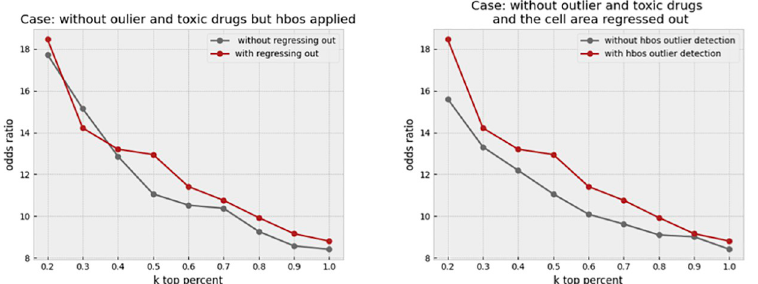
Fig 15. The combined effect of outlier detection and regressing-out. The left plot shows the effect of regressing out when all other preprocessing steps (outlier and toxic drug removal, and cell outlier removal) are applied. The right plot shows the effect of cell outlier removal when all other steps, including outlier and toxic drug removal and regress-out, have been applied. Cell outlier removal seems to provide a more consistent improvement across values of k compared to the regress-out technique.